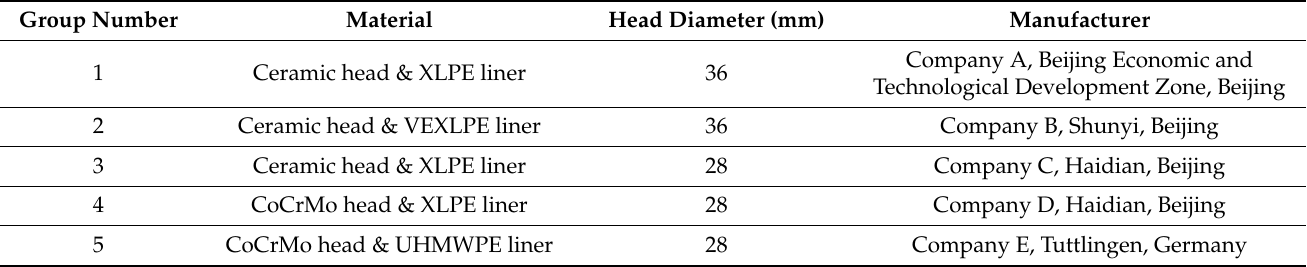
Table 1. Prosthesis combinations used in this